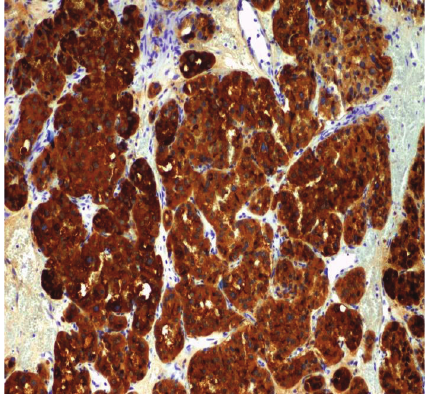
Figure 2: Immunohistochemical positivity for Thyroglobulin.